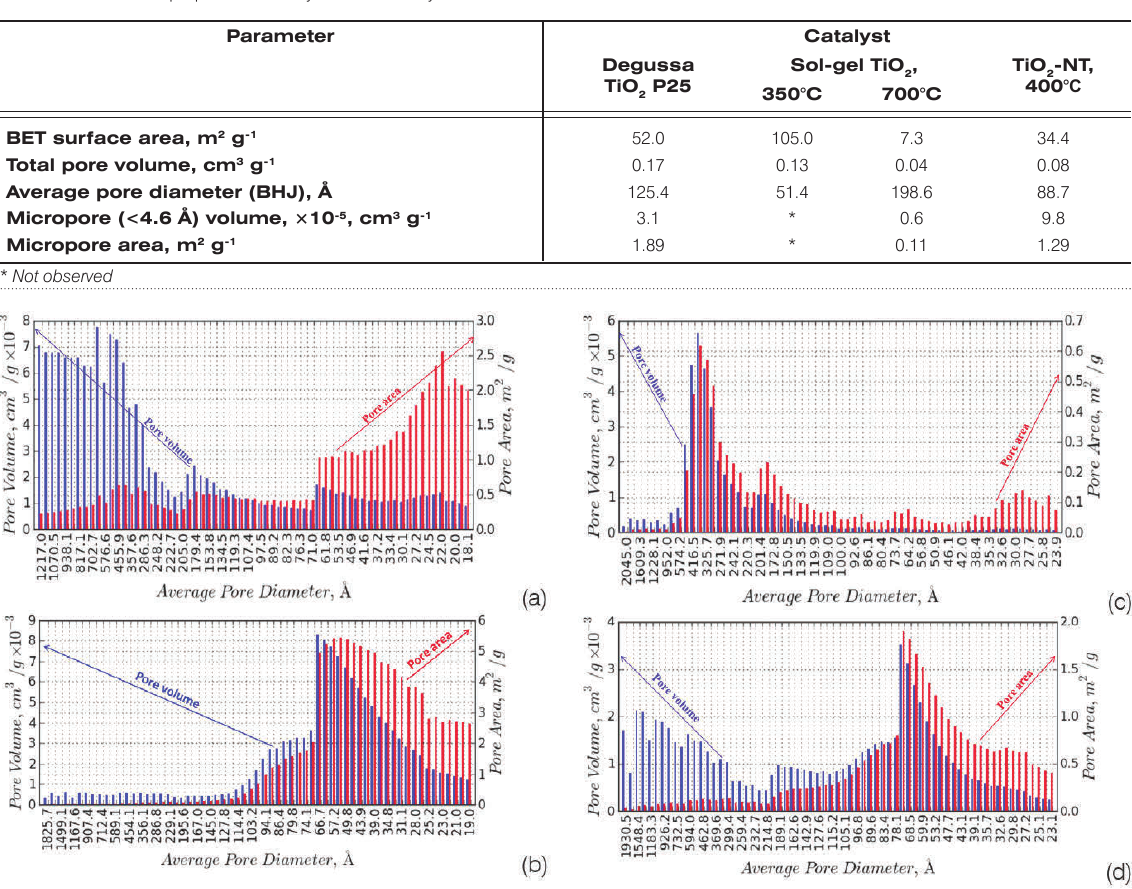
Figure 9. Pore volume and surface area distribution as a function of pore diameter for Degussa TiO at 350 o C (b) and 700 o C (c) and TiO